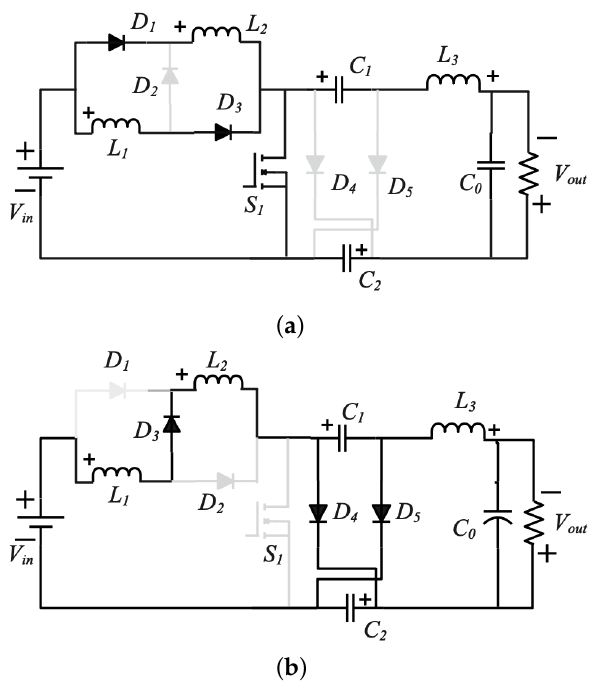
Figure 5. Topology 1: Operating mode of SLSC CUK converter ( a ) ON Mode ( b ) OFF